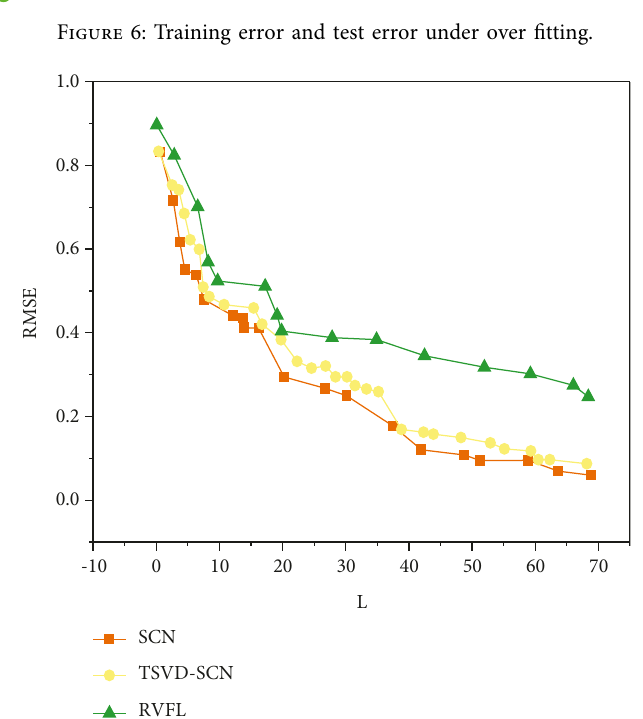
Figure 7: Training root mean square error.